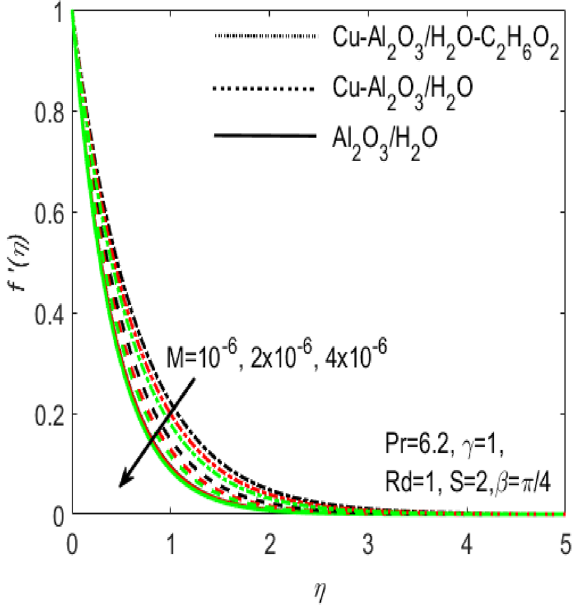
Figure 1. Influence of M on f ′ (η) for different hybrid nanofluids and simple